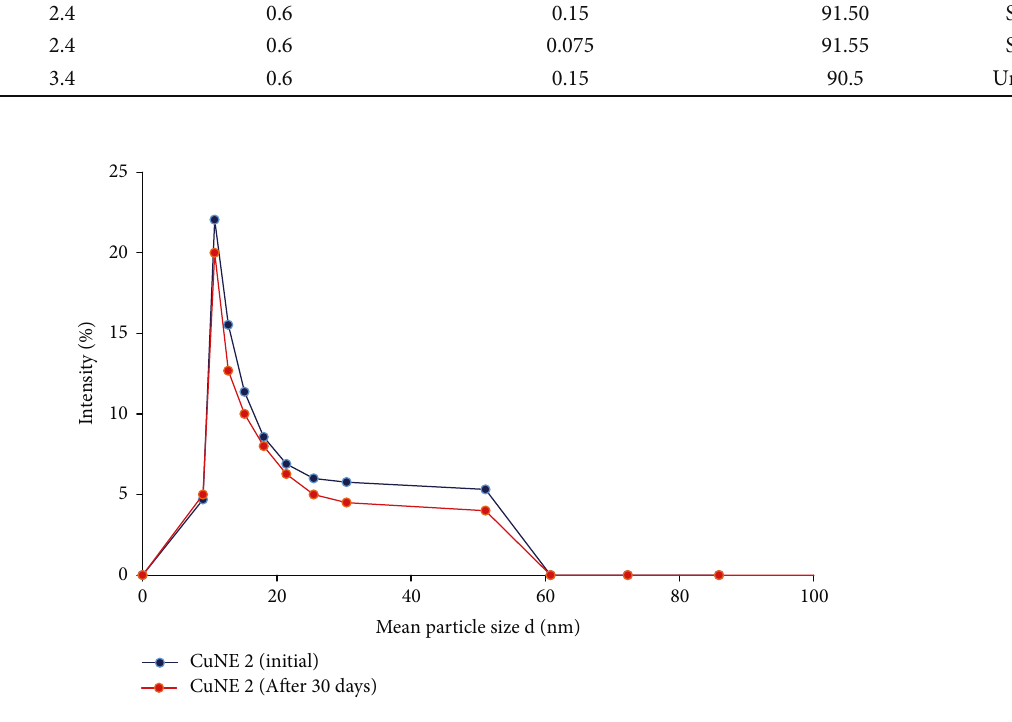
Figure 1: Stability data of nanoemulsion sample in term of PSD.